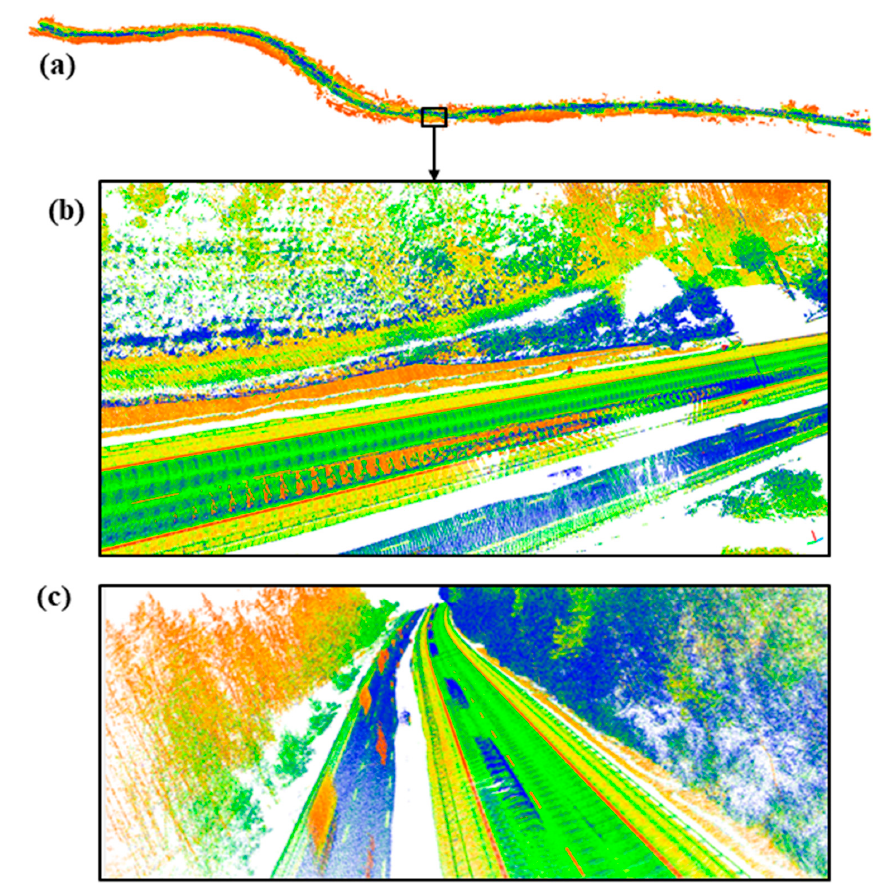
Figure 2. MLS dataset: ( a ) full data; ( b ) and ( c ) enlarged fragment from different perspectives. The MLS dataset has been processed by means of OptD and random reduction in CloudCompare (CC), leading to the results shown in Table 1.